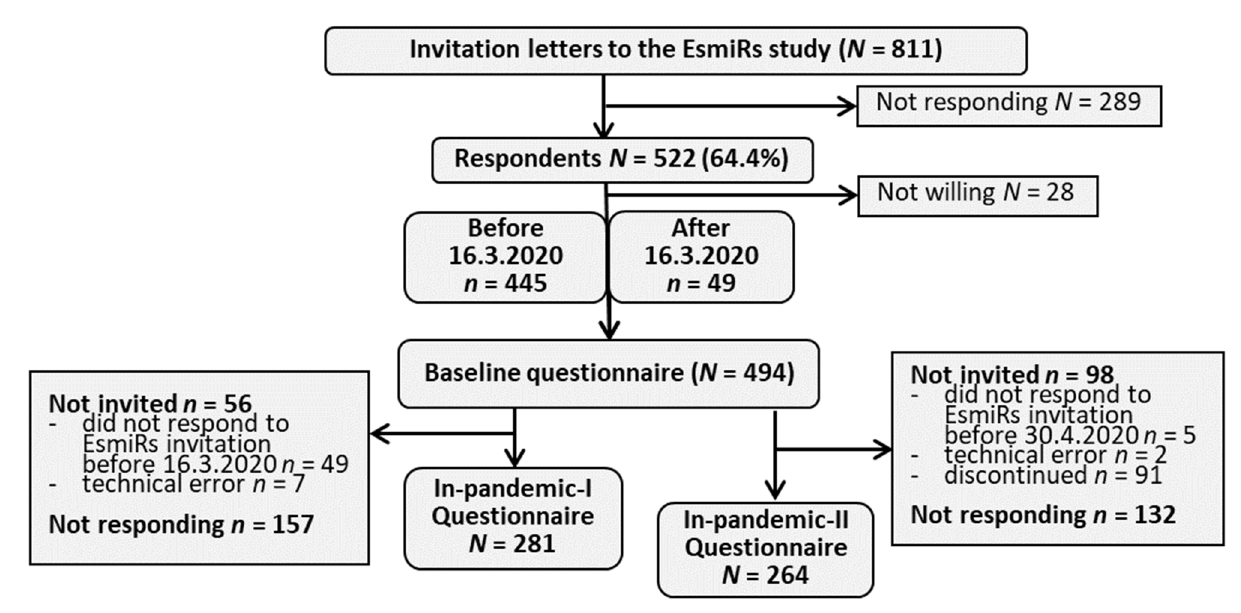
Figure 2. Flow of participants. Figure legend: The flow shows the number of participants who responded to the EsmiRs study invitation before and after the Finnish government announced the emergency conditions. Excluded from the longitudinal analysis of the current study were 49 participants who responded after 16 March 2020 and 4 participants who had filled in the pre-pandemic EsmiRs questionnaire after 16 March 2020.